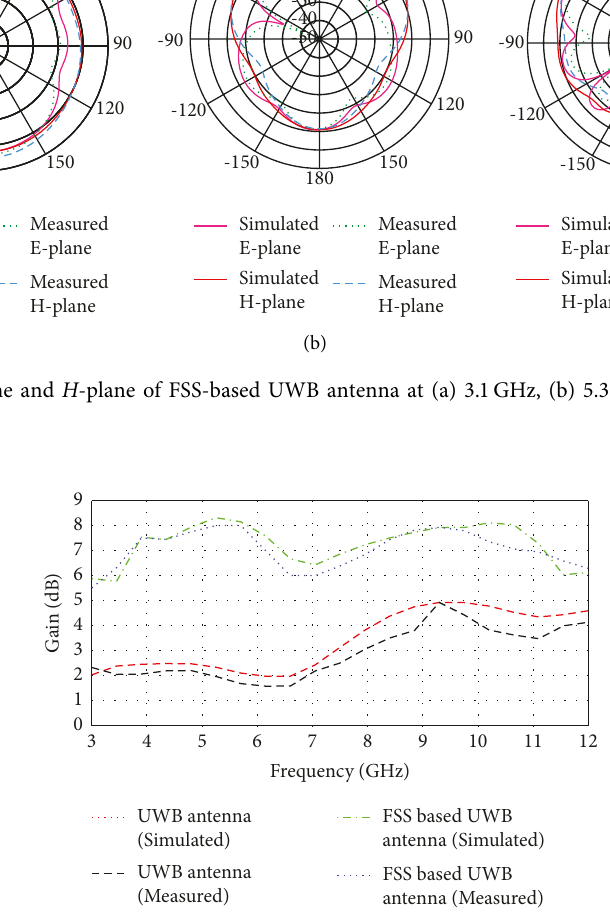
Figure 11: Tested and theoretical gain (dB) of antenna with and without